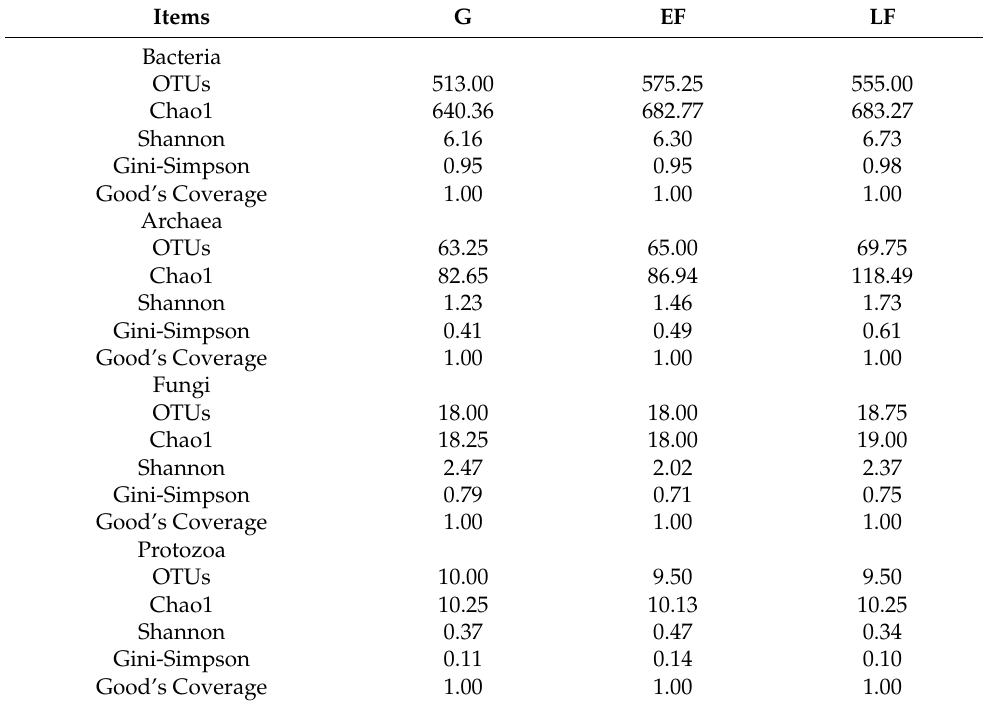
Table 4. Rumen microbial diversities from Hanwoo steers according to different growth